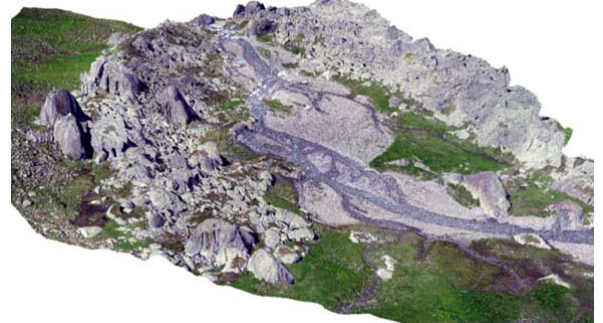
Figure 5: Resulting DSM Generated with